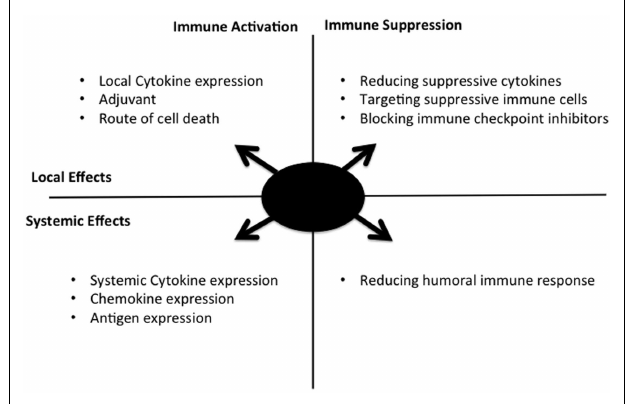
FIGURE 1 | Selective replication of an oncolytic virus within an infected tumor cell might be engineered in multiple ways to optimize the kinetics, type, and level of resultant immune response .The approaches covered in this perspective are summarized here, along with their range of activity (local acting within the tumor, or systemic activity) and whether immune activation or blocking of immune suppression are involved. Ideal combination approaches would be predicted to involve components of different quadrants in the